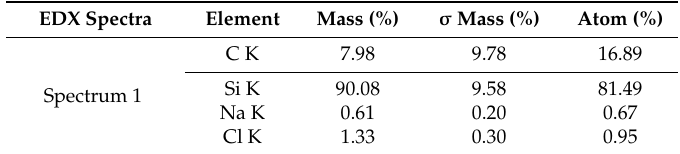
Figure 3. ESEM image to demonstrate morphological behaviour of cells on the sample structure. The circles in the images show cellular extension along the fibres.